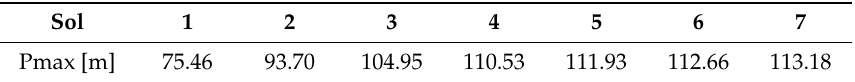
Table 13. Maximum nodal pressures of BIN solutions.